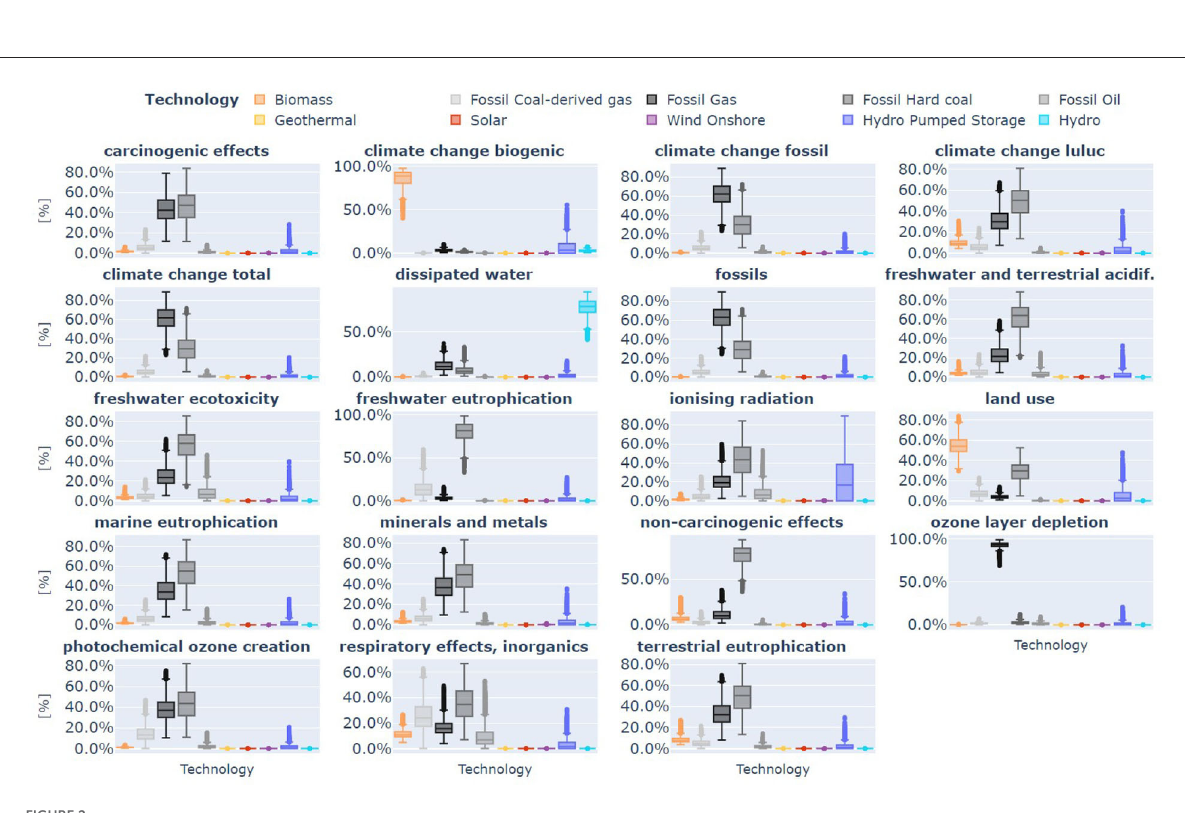
FIGURE2 The distribution of hourly share of LCA impact of a certain technology on the hourly LCA impact represented by box plots, for each LCA impact